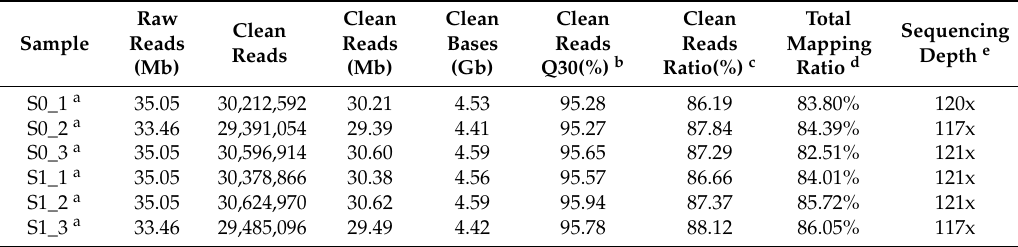
Table 1. Summary of sequencing